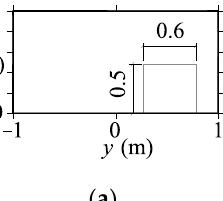
Figure 3. Schematic of the configurations with vehicular blockages: ( a ) One side with vehicular blockage, M1 ; ( b ) Both sides with vehicular blockage, M2 .